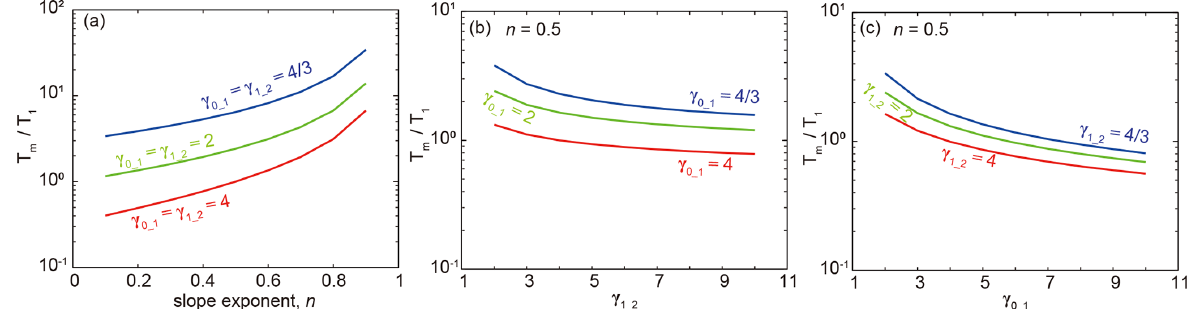
Figure 3. The duration of concave knickpoint preservation as a function of the slope exponent n (a) , γ 1_2 (b) and γ 0_1 (c) , under decreasing U and n< 1. In (a) , the steepness ratios are equal, γ 1_2 = γ 0_1 . In panels (b) and (c) , n = 0 .